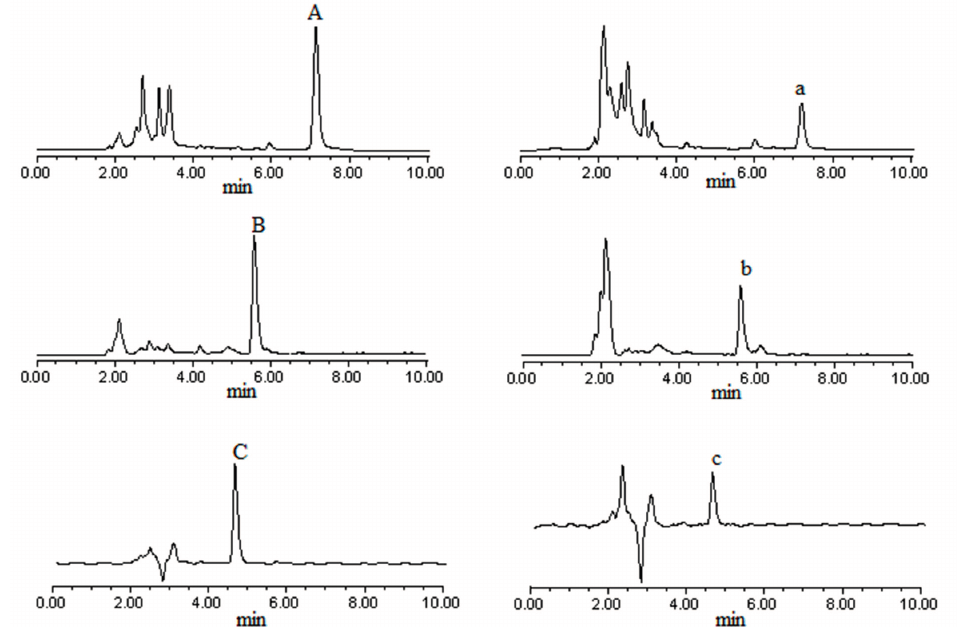
Figure 2. HPLC chromatograms of PA, GA and TS.